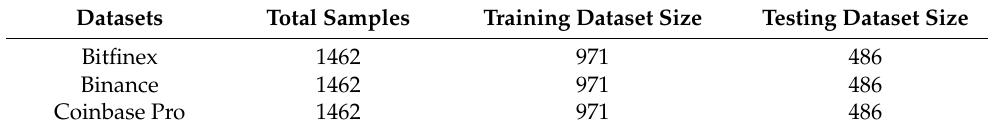
Table 1. Dataset Descriptions.